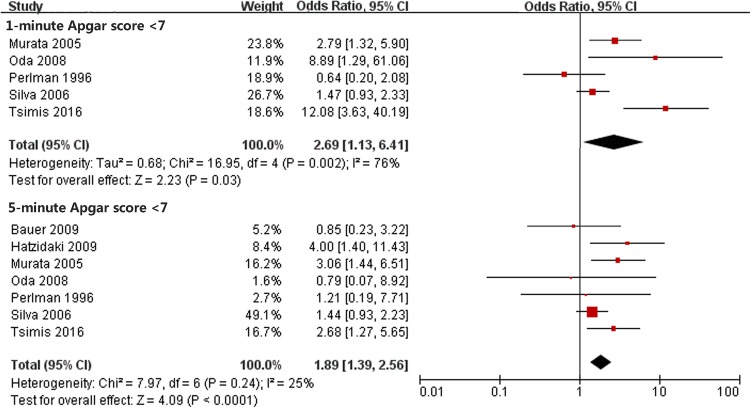
Forest plot of the odds ratio of the association between low Apgar score and PVL.A random-effect model was used to assess the association between low Apgar score at 1 minute and PVL. A fixed-effect model was used to assess the association between low Apgar score at 5 minutes and PVL. The pooled OR of low Apgar score is presented as a solid diamond at the bottom of the forest plot, the width of which represents the 95% CI.